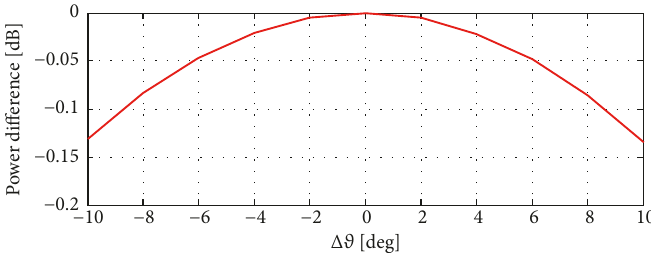
Figure 12: Pilot tone power versus (cid:2) 𝜗 (P Rx = −19.4 dB, L = 60 km, (cid:2) 𝛼 PDL = 0.03 dB, and f BR = 10 Gbit / s).